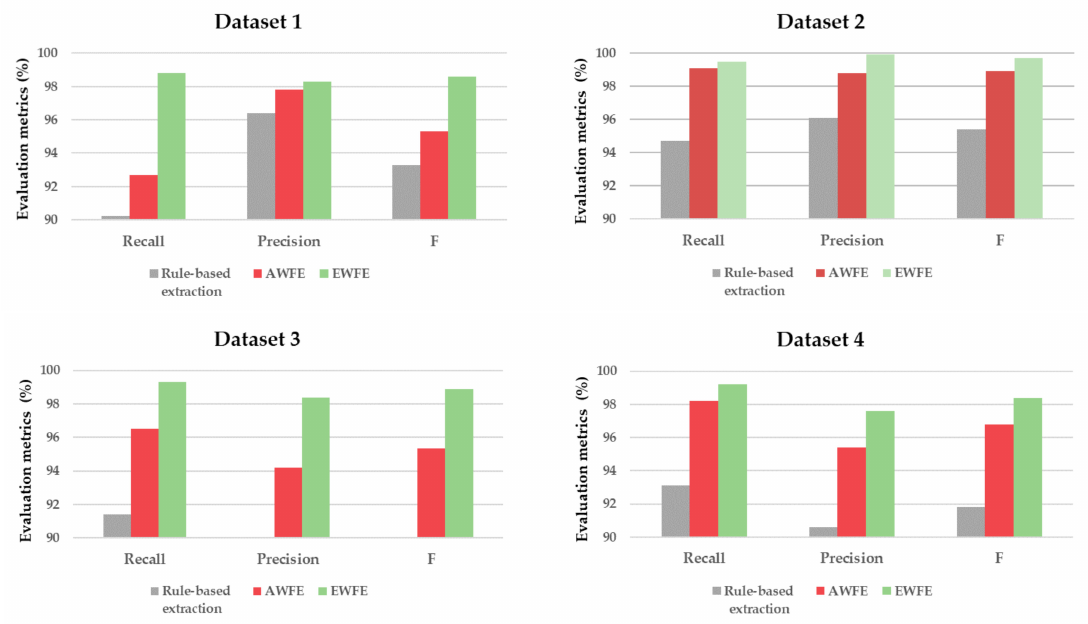
Figure 12. The comparison of the evaluation metrics of the rule-based extraction, AWFE and the proposed EWFE extrac- tion